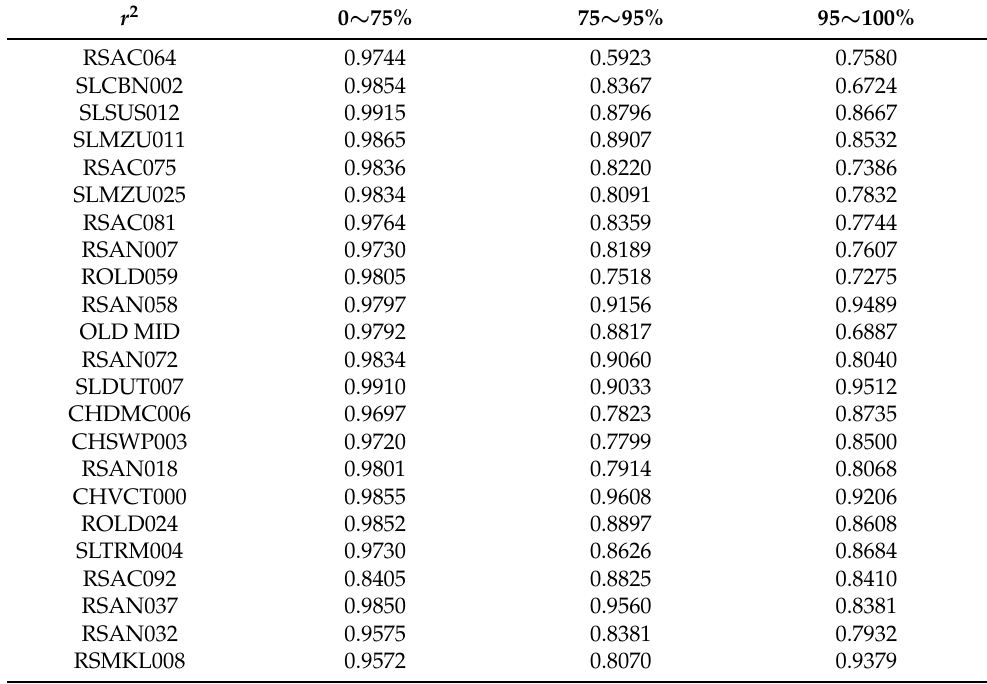
Table A6. Station-wise r 2 results of Res-LSTM at daily time